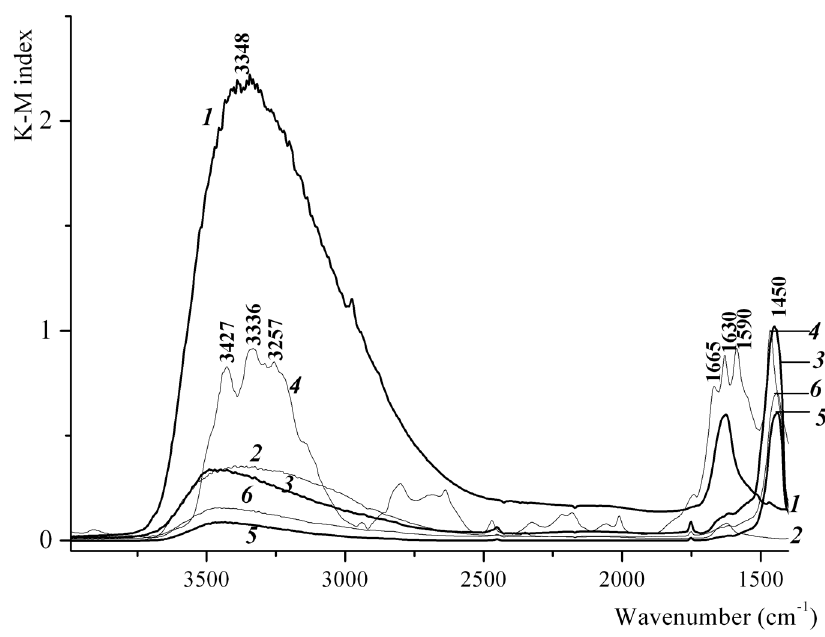
Figure 3. FTIR spectra for different TiO : amorphous (1), anatase (2), anatase+brookite (3), anatase+rutile (4), brookite (5), rutile (6). 2